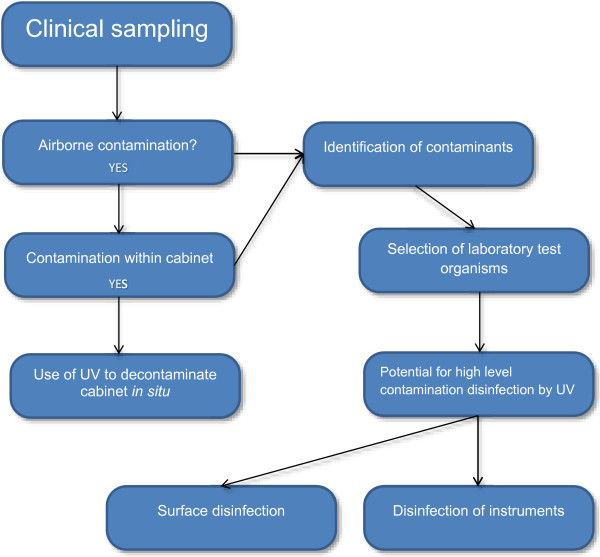
Scheme of work included in the study.